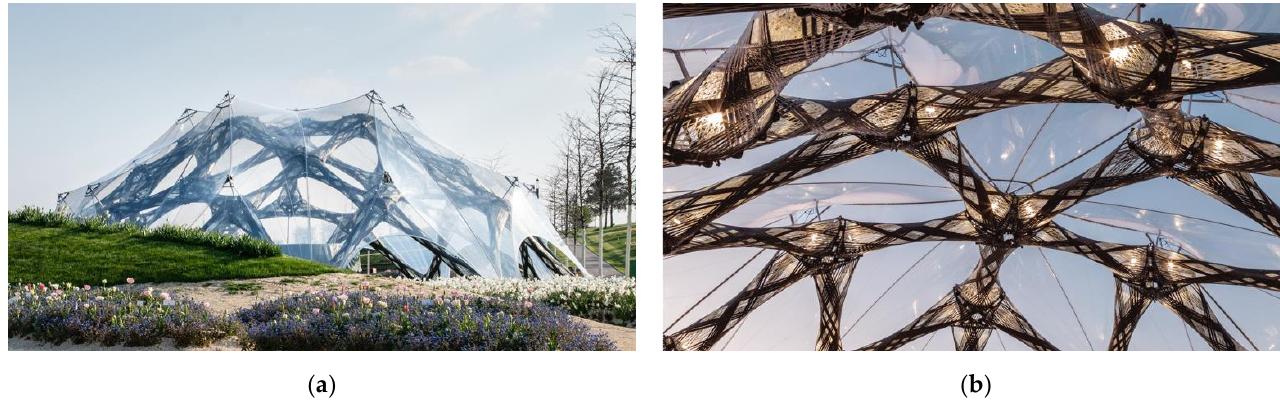
Figure 2. BUGA Fiber Pavilion: ( a ) photograph of the north side exterior of the pavilion during day; ( b ) interior view during twilight. © ICD/ITKE University of Stuttgart.